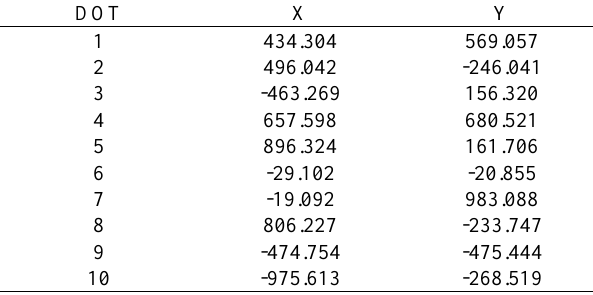
Table 2 The 2D coordinates of reflectors measured by digital